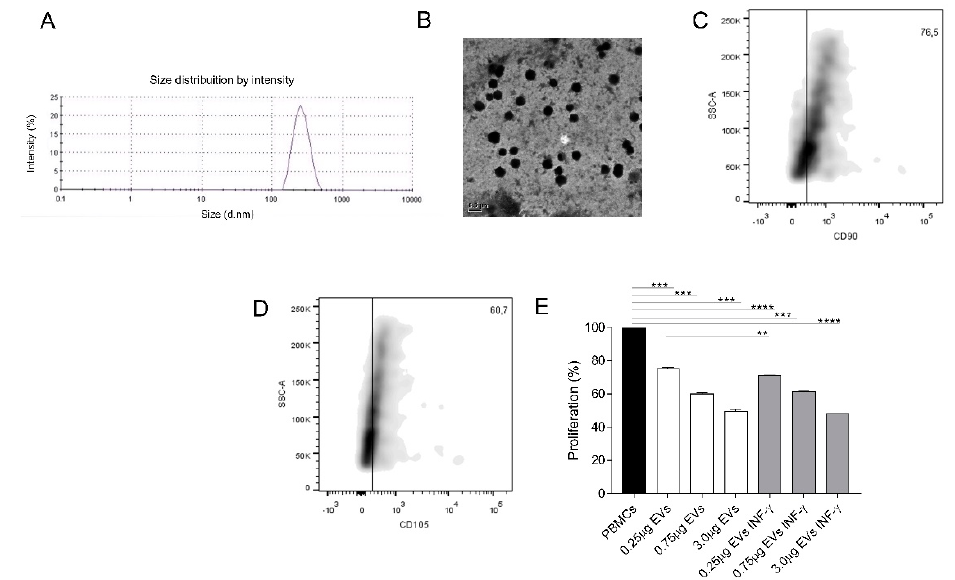
Figure 5. Characterization of EVs isolated from unlicensed and INF- γ licensed AMSCs and their capacity to control T-cell proliferation. ( A ) EVs average size estimated using Zetasizer Nano ZS; ( B ) Transmission electron microscopy of EVs (representative image of one unlicensed sample); CD90 ( C ) and CD105 ( D ) expression of EVs isolated from unlicensed AMSCs were determined by Flow Cytometry; ( E ) EVs isolated from unlicensed and INF- γ licensed AMSCs were quantified according to their protein concentration by Bradford assay and used in different concentrations (0.25, 0.75 and 3.0 µ g) to treat PHA-activated PBMCs, in order to access their immunosuppressive capacity. Results are presented as mean ± SEM of three independent experiments. ** p < 0.01, *** p < 0.001 **** p < 0.0001.